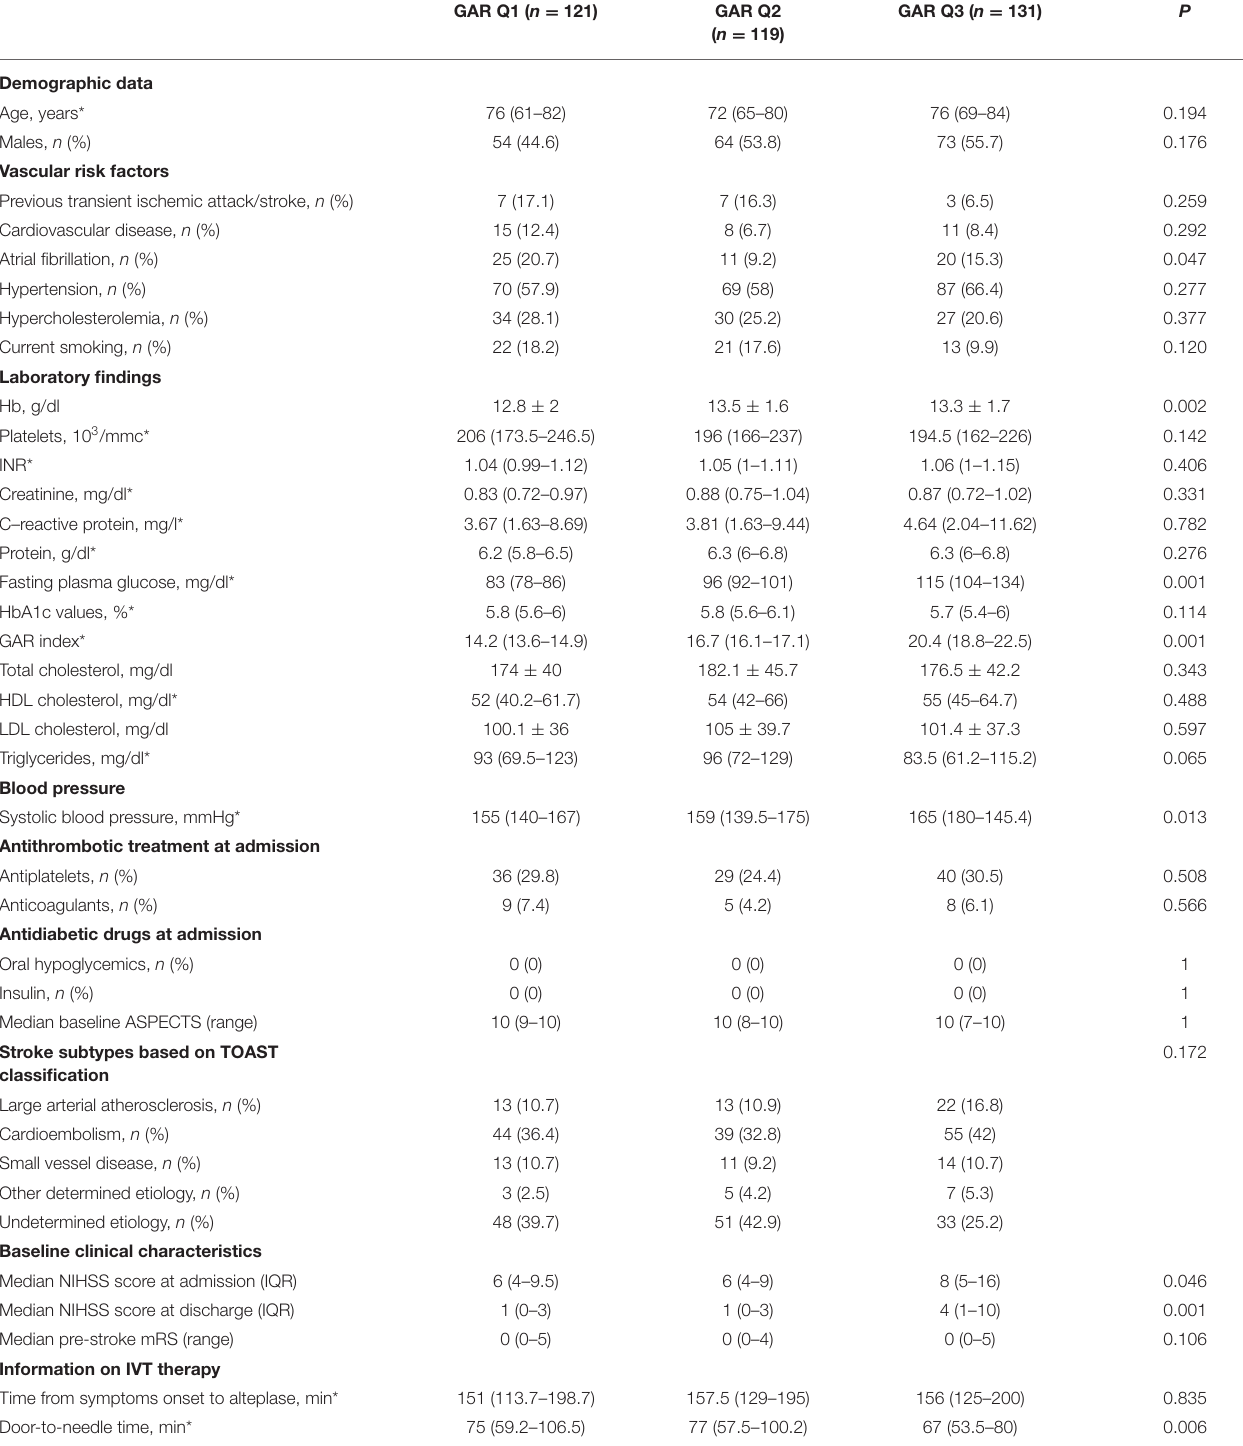
TABLE 2 | General characteristics of 371 non–diabetic patients according to the GAR